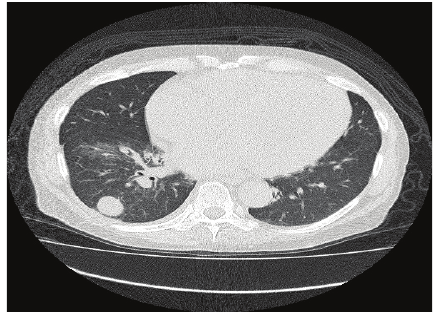
Figure 4: CT scan 12 months after stopping